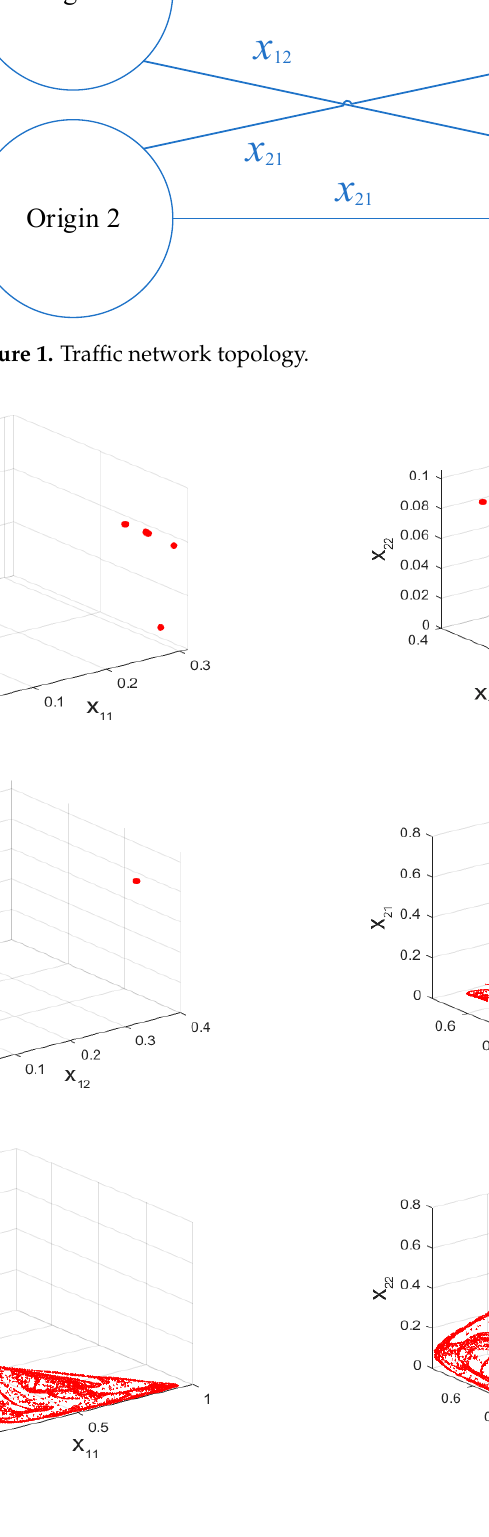
Figure 2. The phase trajectory of model 1: ( a – c ) α = 1, β = 3.25, µ = 6.5, γ = 1.69; ( d – f ) α = 1, β = 3.25, µ = 6.5, γ =